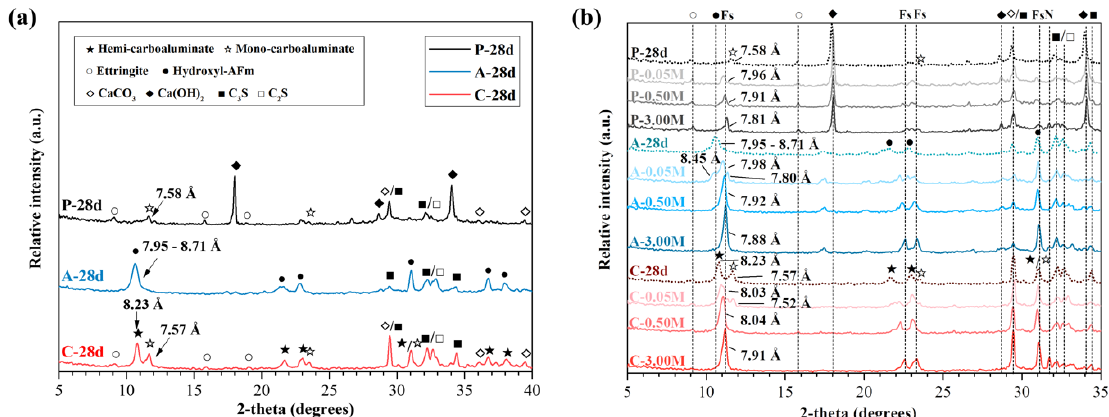
Figure 4. XRD patterns of P, A and C ( a ) at 28 days; ( b ) chloride contaminated samples with 0.05, 0.50 and 3.00 M chloride concentrations in which ★ : hemi-carboaluminate, ☆ : mono-carboaluminate, ○